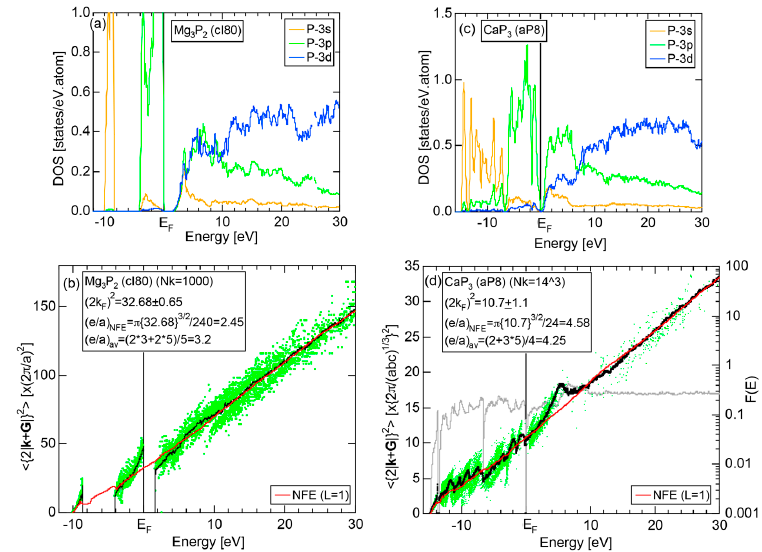
Figure 75. ( a ) P-pDOSs and ( b ) Hume-Rothery plot for Mg 3 P 2 (cI80). ( c ) P-pDOSs and ( d ) Hume-Rothery plot for CaP 3 (aP8). See captions of Figure 19 (b) for symbols in (b) and (d).